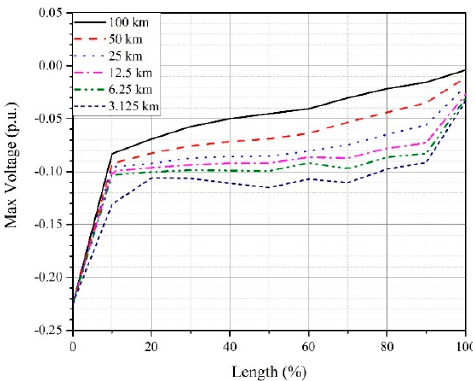
Figure 14. Maximum sheath-ground voltage along the length in cables with different lengths.